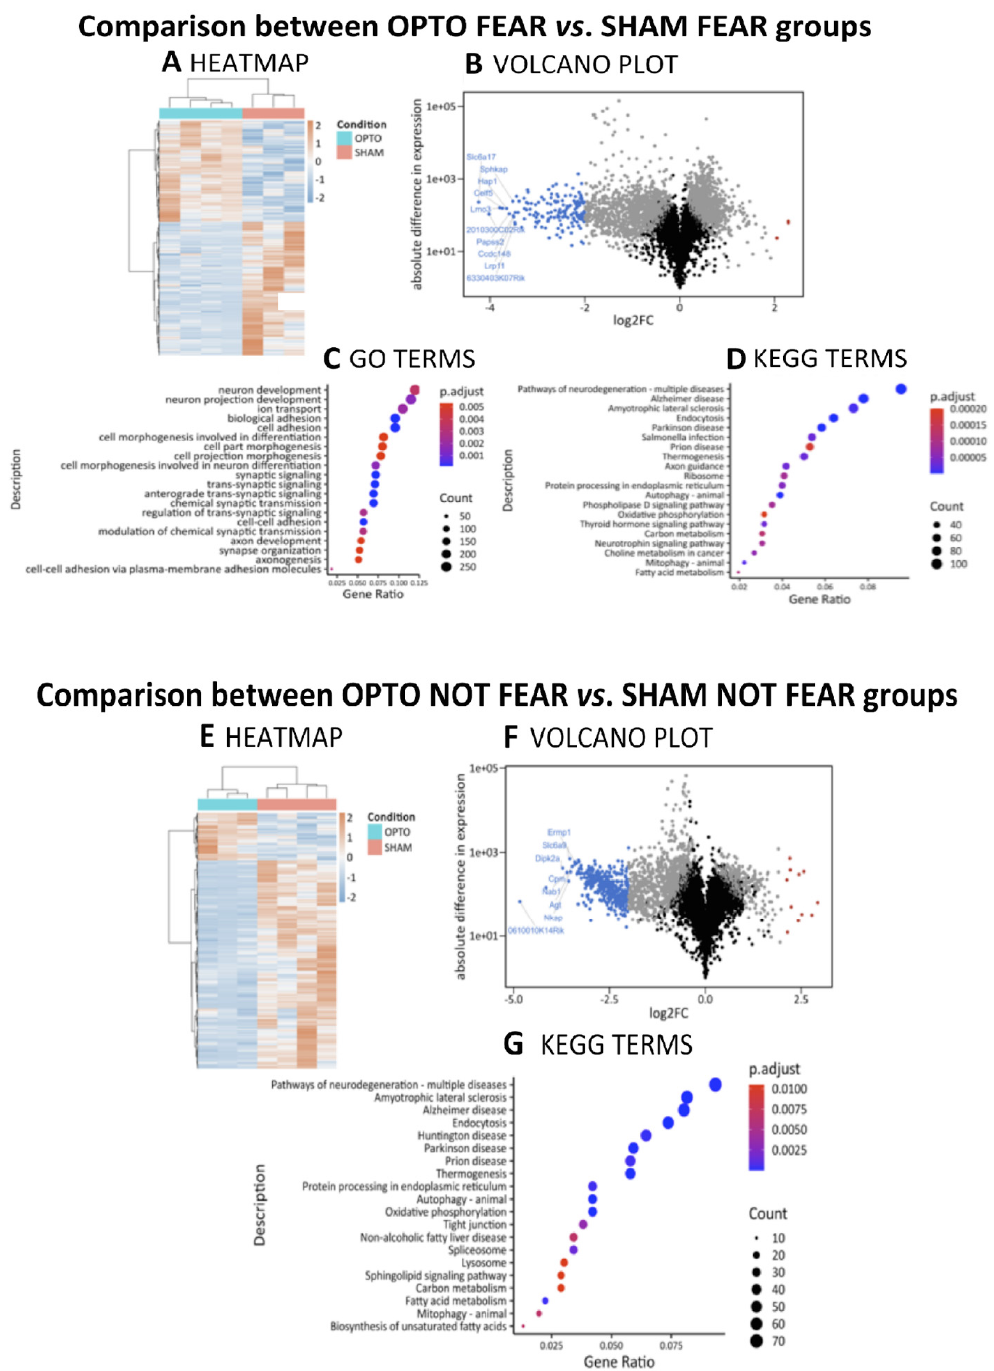
Figure 5. Differential Gene Expression profiling and functional enrichment analysis of RNA extracted by amygdala pyramidal neurons. Comparisons between OPTO FEAR vs. SHAM FEAR groups (upper part) and OPTO NOT FEAR vs. SHAM NOT FEAR groups (lower part). ( A , E ) Heatmaps showing gene expression values for the Differentially Expressed Genes (DEGs). ( B , F ) Volcano plots highlighting DEGs. The x -axis is the log2 fold change (log2FC) in normalized gene expression and the y -axis is for the log 10 absolute value of the difference in expression between conditions. Each dot represents a gene. Grey dots are for DEGs, blue and red dots are for < − 2 and >+2 log2FC genes, respectively. The top ten genes with the highest absolute log2FC values are labeled. ( C , D , G ) Dot plots representing the top twenty enriched terms from over-representation analyses (ORA) in Gene Ontology (GO) and Kyoto Encyclopedia of Genes and Genomes (KEGG) databases. GO terms from different domains (Biological Processes, Cellular Component, and Molecular Function) were sorted by q -value before plotting them